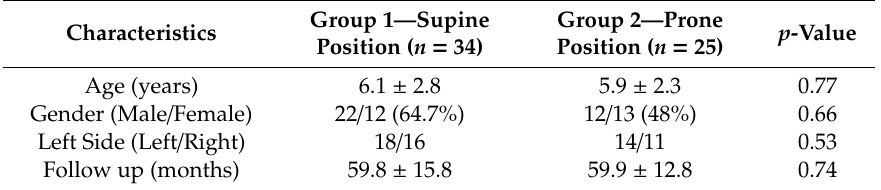
Table 1. Groups demographics characteristics.